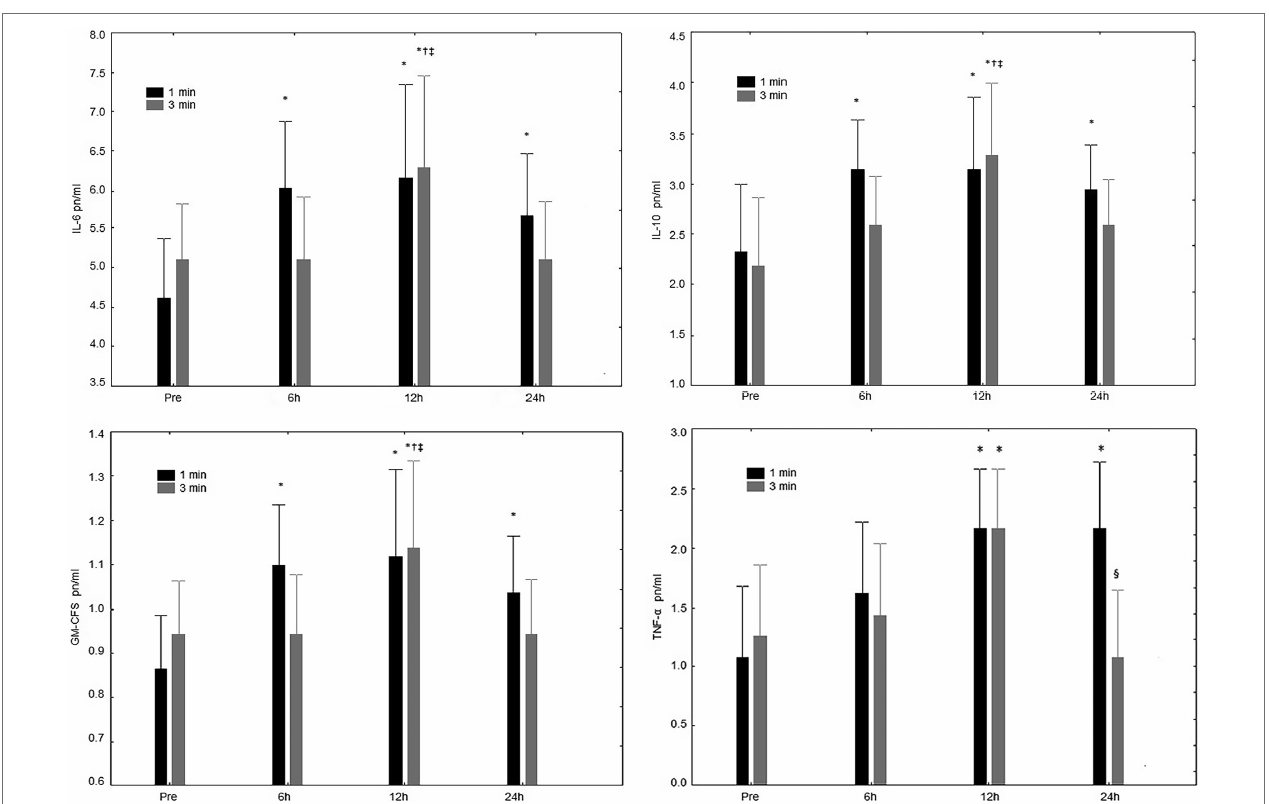
FIGURE 3 | IL-5 pn/ml Interleukin-6 (IL-6) concentrations at pre-exercise (Pre), 3, 6, 12, and 24 h after completing five sets of bench press and leg press exercises with 1 or 3 min of rest between sets. IL-10 pn/ml Interleukin-10 (IL-10) concentrations at pre-exercise (Pre), 3, 6, 12, and 24 h after completing five sets of bench press and leg press exercises with 1 or 3 min of rest between sets. GM-CFS pn/ml Granulocyte-macrophage colonystimulating factor (GM-CSF) concentrations at pre-exercise (Pre), 3, 6, 12, and 24 h after completing five sets of bench press and leg press exercises with 1- or 3-min of rest between sets. TNF- α pn/ml Tumoral necrosis factor (TNF- α ) concentrations at pre-exercise (Pre), 3, 6, 12, and 24 h after completing 5 sets of bench press and leg press exercises with 1- or 3-min of rest between sets. *Significant difference to Pre ( p ≤ 0.05); † Significant difference to 6 h ( p ≤ 0.05); § Significant difference to 12 h ( p ≤ 0.05); and ‡ Significant difference to 24 h ( p ≤